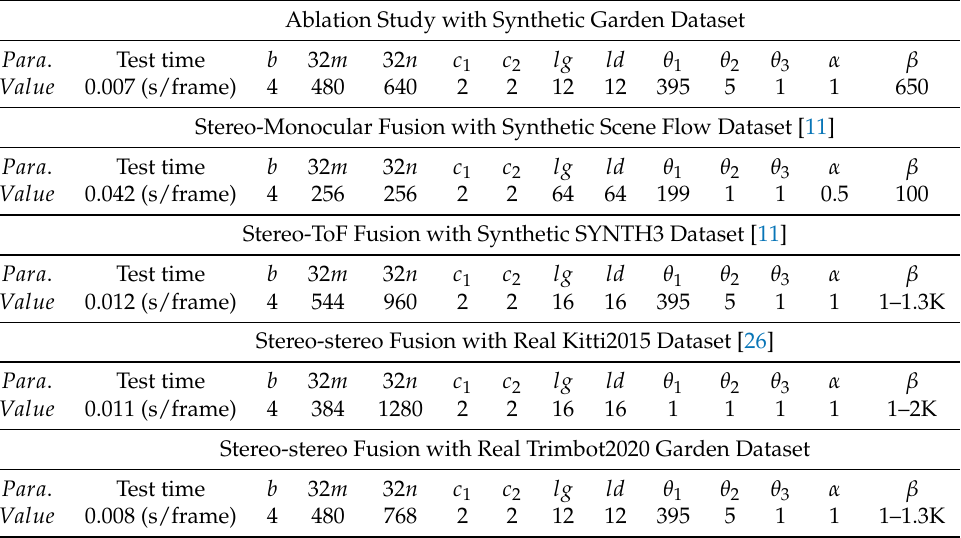
Table 2. Computation Time and Parameter